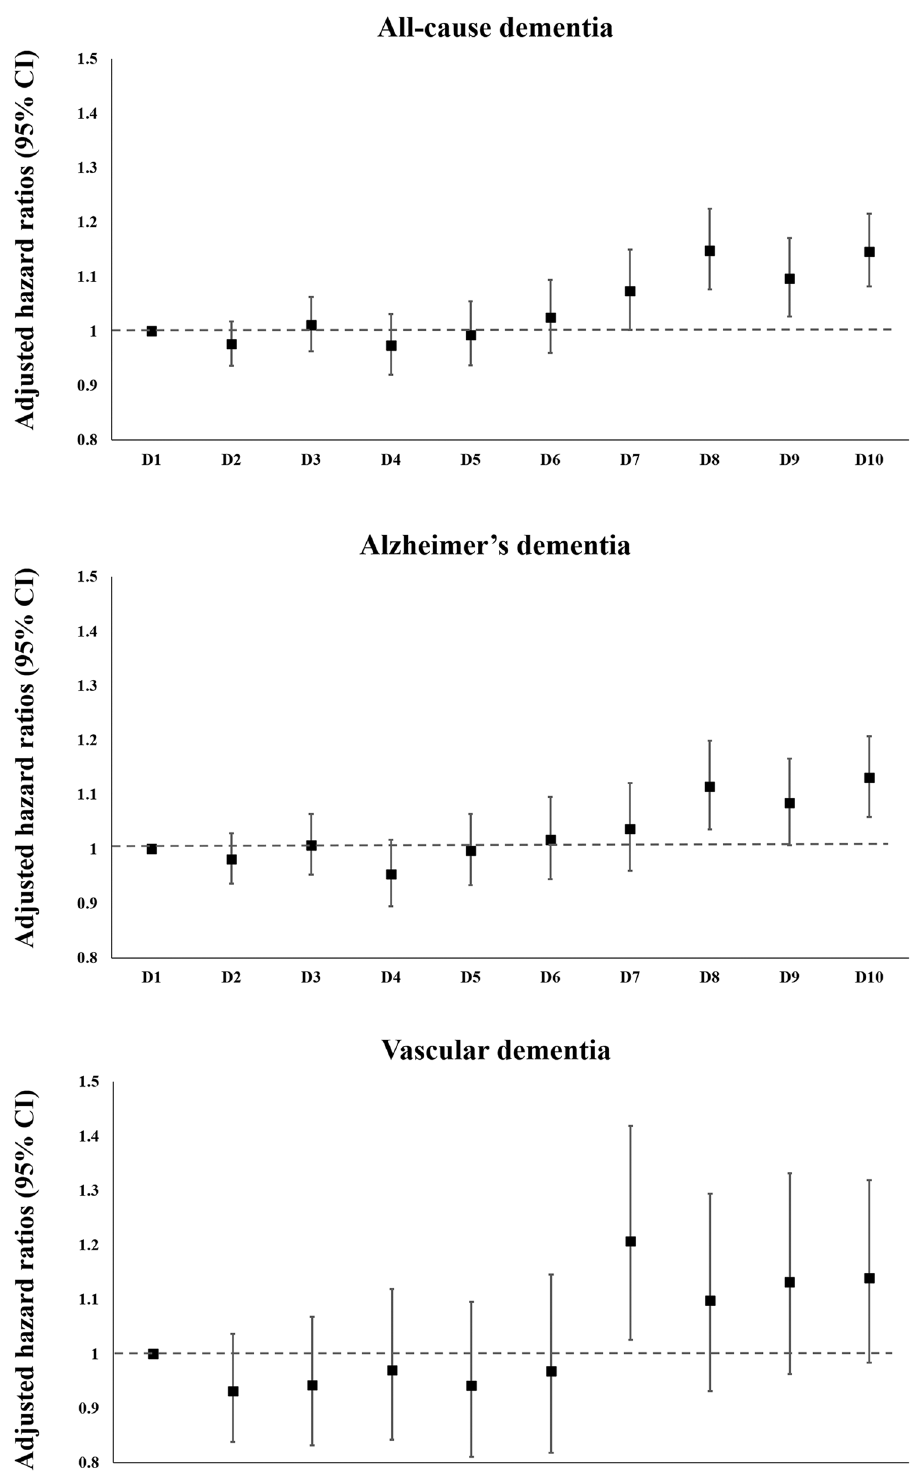
Figure 3. Hazard ratios for the incidence of all-cause dementia, Alzheimer’s disease, and vascular dementia among statin users with diabetes according to deciles of low-density lipoprotein cholesterol level. Adjusted for age, sex, body mass index, hypertension, current smoking status, alcohol consumption status, regular exercise, and estimated glomerular filtration rate. *LDL-C decile ranges: D1 (LDL-C < 75 mg/dl), D2 (75 mg/ dl ≤ LDL-C < 89 mg/dl), D3 (89 mg/dl ≤ LDL-C < 99 mg/dl), D4 (99 mg/dl ≤ LDL-C < 107 mg/dl), D5 (107 mg/ dl ≤ LDL-C < 116 mg/dl), D6 (116 mg/dl ≤ LDL-C < 124 mg/dl), D7 (124 mg/dl ≤ LDL-C < 133 mg/dl), D8 (133 mg/dl ≤ LDL-C < 145 mg/dl), D9 (145 mg/dl ≤ LDL-C < 162 mg/dl), D10 (LDL-C ≥ 162 mg/dl). LDL-C low- density lipoprotein cholesterol, CI confidence